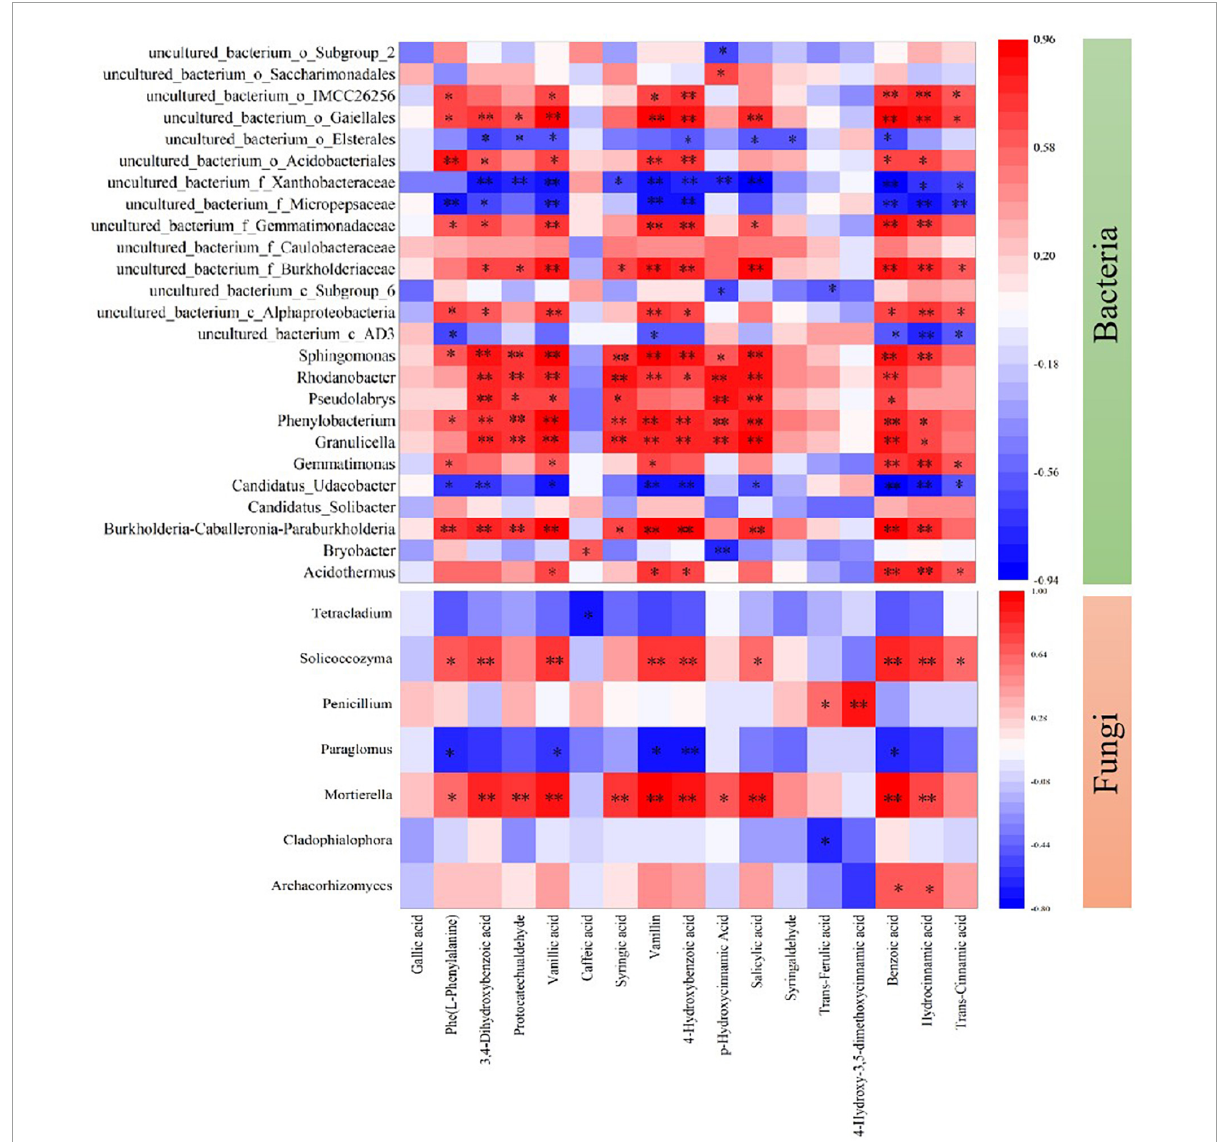
FIGURE8 Spearman’s rank-order correlation between the content of phenolic acids and the relative abundance of dominant bacteria and fungi at the genus level. Only statistically significant correlations are present, and the key from green to red represents the negative correlation to the positive correlation. MC, amendment of manure compost at 20 t ha − 1 ; PB, WB, and MB, amendment of pig manure, wood, and maize biochar at 20 t ha − 1 . ∗ p < 0.05; ∗∗ p <